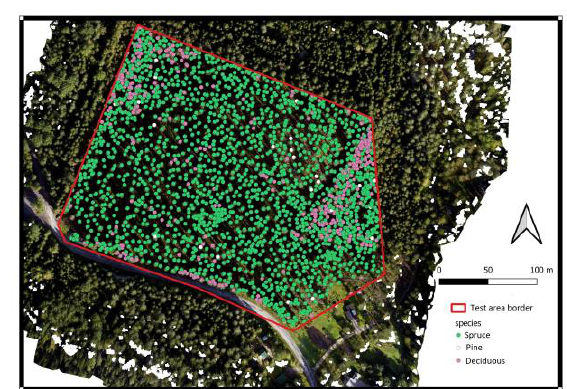
Figure 7. Species classification in the study area. Total number